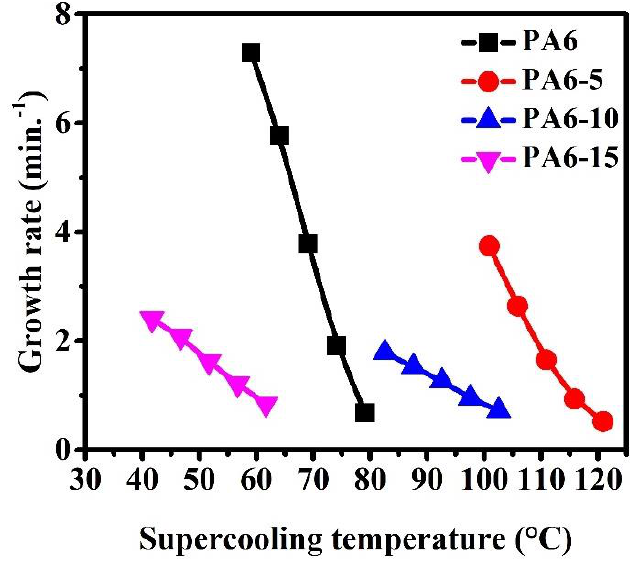
Figure 5. The growth rate of crystallization ( G ) versus the supercooling temperature ( ∆ T ) for all of the polyamides.